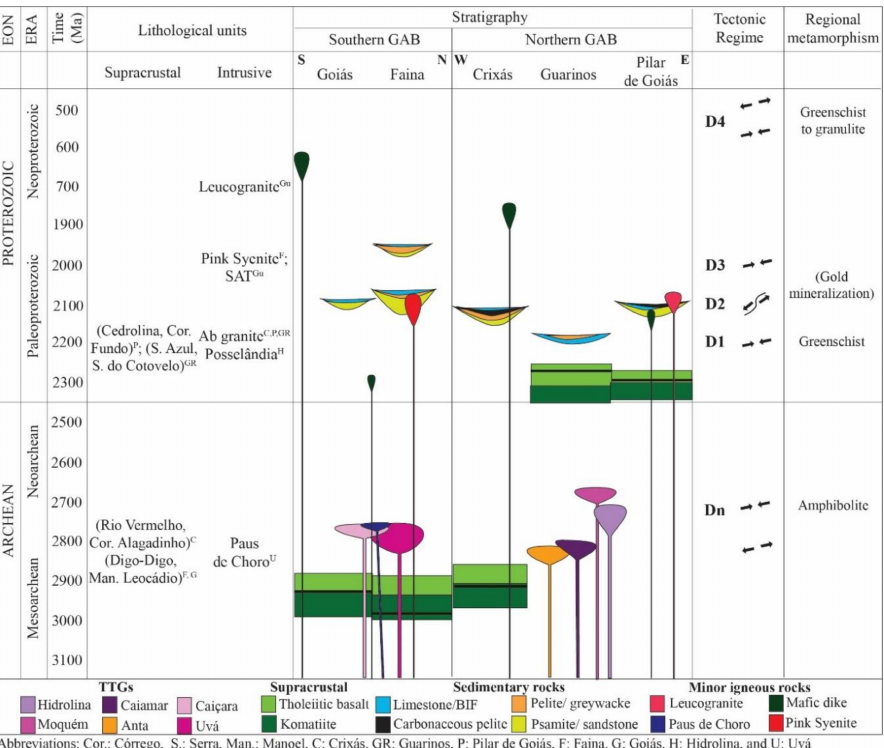
Figure 2. Stratigraphic columns for the greenstone belts in the northern and southern Goi á s Archean Block (GAB). Age compilation for greenstone belts according to [11,18,71,77,82,83]. Age references for the TTGs based on [11,22,24,25,72] and this